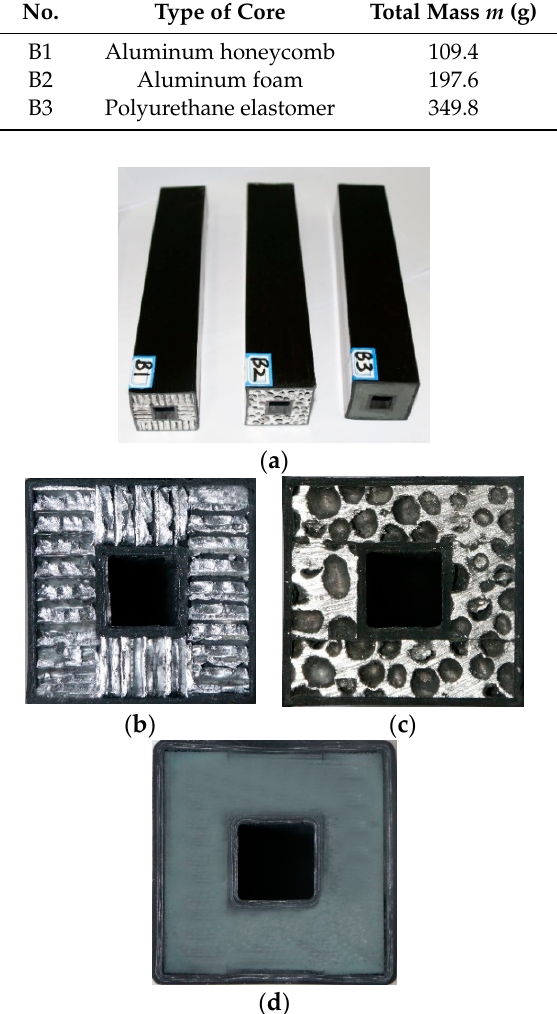
Figure 1. Composite sandwich laminated box beams with three different core materials: ( a ) composite sandwich laminated box beam specimens; ( b ) aluminum honeycomb core; ( c ) aluminum foam core; ( d ) polyurethane elastomer core.